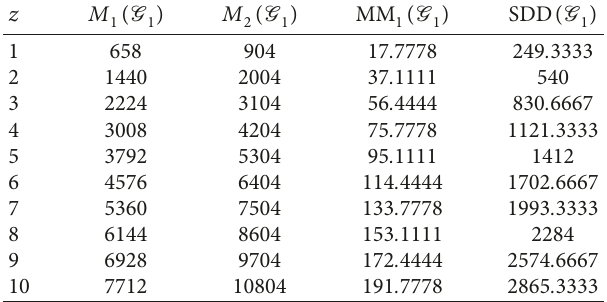
Table 7: Comparison among different TIs of (TM-TCNB) 1 .